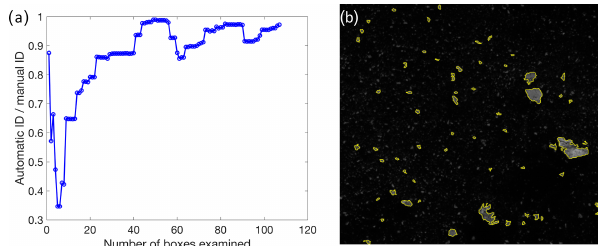
Figure 2. (a) The ratio of automatic iceberg detections to manual iceberg detections as a function of the cumulative number of test boxes counted (each box is 250 × 250 pixels). The total number of test boxes counted was 107. (b) Example of iceberg detection by algorithm. Gray “blotches” not outlined in yellow are too small to be identified as icebergs, and are thus classified as mélange.